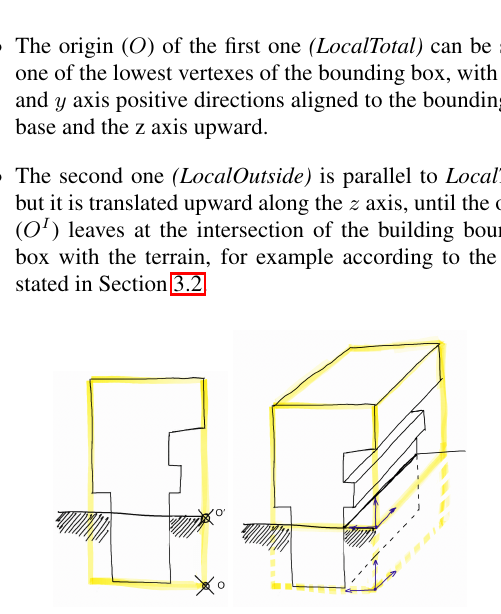
Figure 5. Close look at the facade: horizontal planes (in red) can all be potentially read as discontinuities of vertical surfaces.